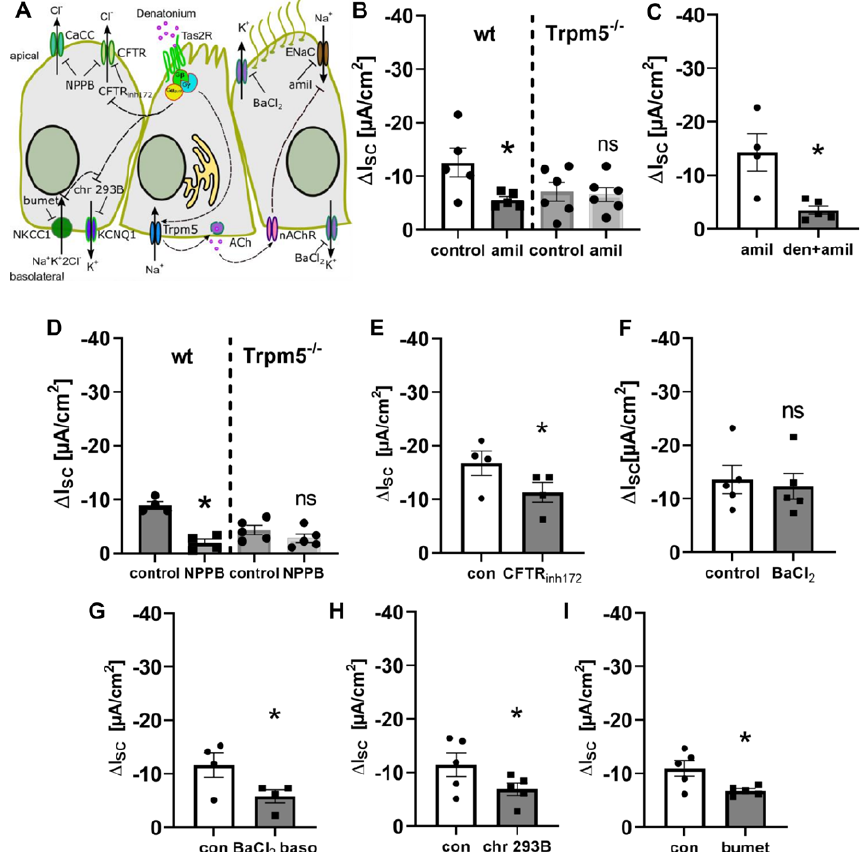
Figure 8. Involvement of ion channels in the denatonium-induced effect. ( A ) Schematic drawing of the influence of the epithelial sodium channel (ENaC) inhibitor amiloride, the Cl − -channel antagonist NPPB, the cystic fibrosis transmembrane conductance regulator (CFTR) blocker CFTR inh172 , and the K + -channel inhibitor BaCl 2 and the KCNQ1 channel antagonist chromanol 293B as well as the inhibitor of the Na-K-2Cl cotransporter 1 (NKCC1) bumetanide. ( B ) The ENaC inhibitor amiloride (10 µ M, apical) reduced the denatonium-induced current in wildtype but not in Trpm5 − / − mice ( ∆ I SC , n = 5–6, * p < 0.05, ns: not significant). ( C ) The effect of amiloride (10 µ M, apical) was significantly reduced in the presence of denatonium (1 mM apical) ( ∆ I SC , n = 4–5, * p < 0.05). ( D ) The Cl − -channel inhibitor NPPB (100 µ M, apical) reduced the denatonium-induced effect in wildtype but not in Trpm5 − / − mice ( ∆ I SC , n = 5–6, * p < 0.05, ns: not significant). ( E ) The CFTR antagonist CFTR inh172 (10 µ M, apical) reduced the denatonium-induced current ( ∆ I SC , n = 4, * p < 0.05, con: control). ( F ) The non-selective K + -channel inhibitor BaCl 2 (5 mM, apical) did not change the denatonium-induced current ( ∆ I SC , n = 5, ns: not significant) compared to the control effect. ( G ) In the presence of 5 mM BaCl 2 on the basolateral side of the epithelium, the denatonium-induced current was reduced ( ∆ I SC , n = 4, * p < 0.05, con: control). ( H ) The KCNQ1 antagonist chromanol 293B (100 µ M, basolateral, chr 293B) reduced the denatonium-induced current ( ∆ I SC , n = 5, * p < 0.05, con: control). ( I ) The NKCC inhibitor bumetanide (200 µ M, basolateral) reduced the denatonium-induced current ( ∆ I SC , n = 5, * p < 0.05, con: